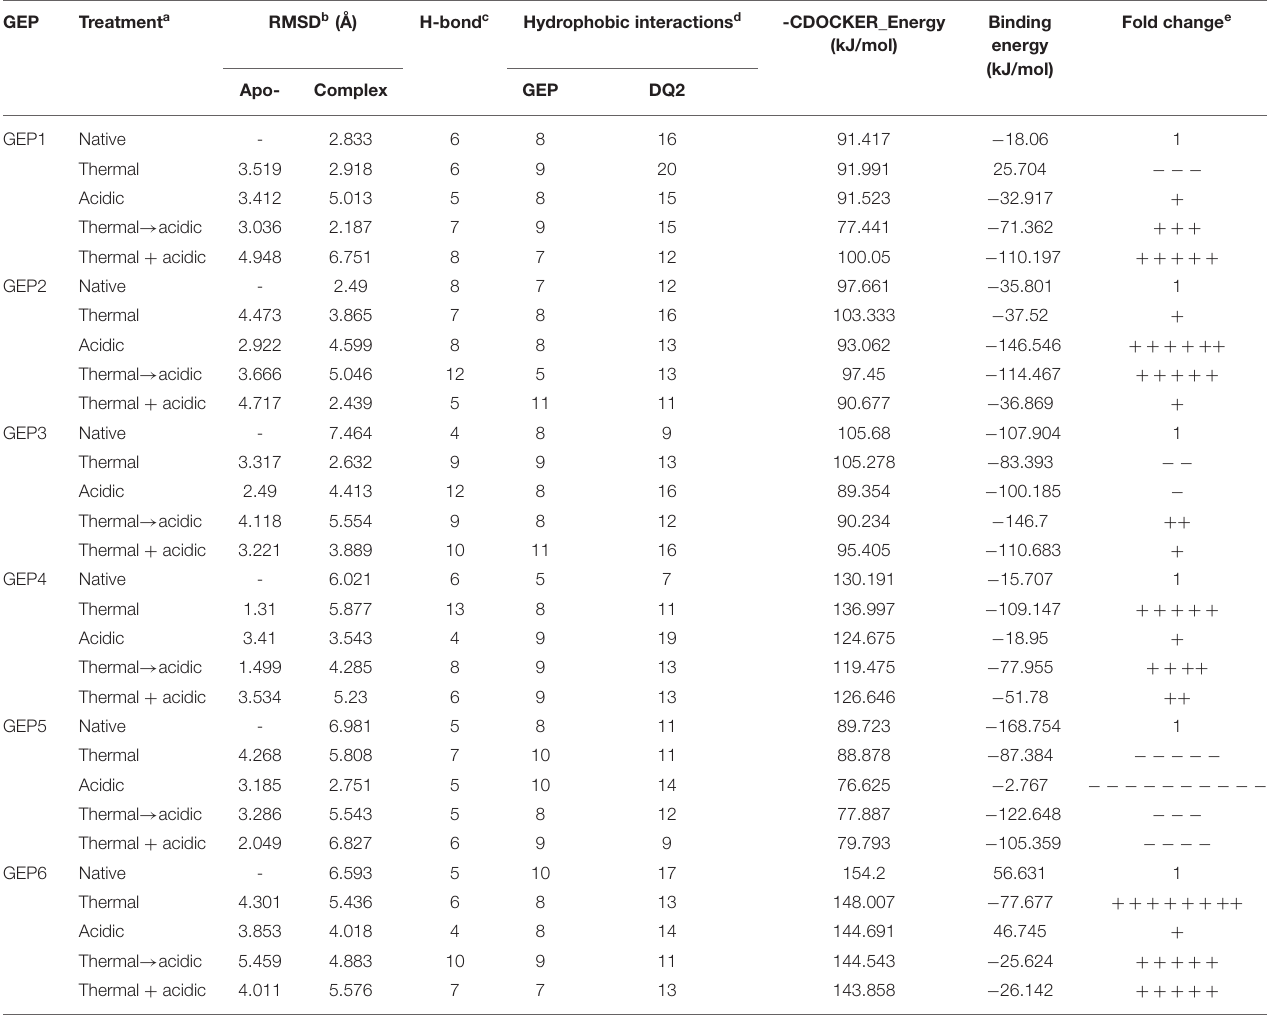
TABLE 1 | Binding parameters of differently treated GEP to HLA-DQ2. GEP Treatment